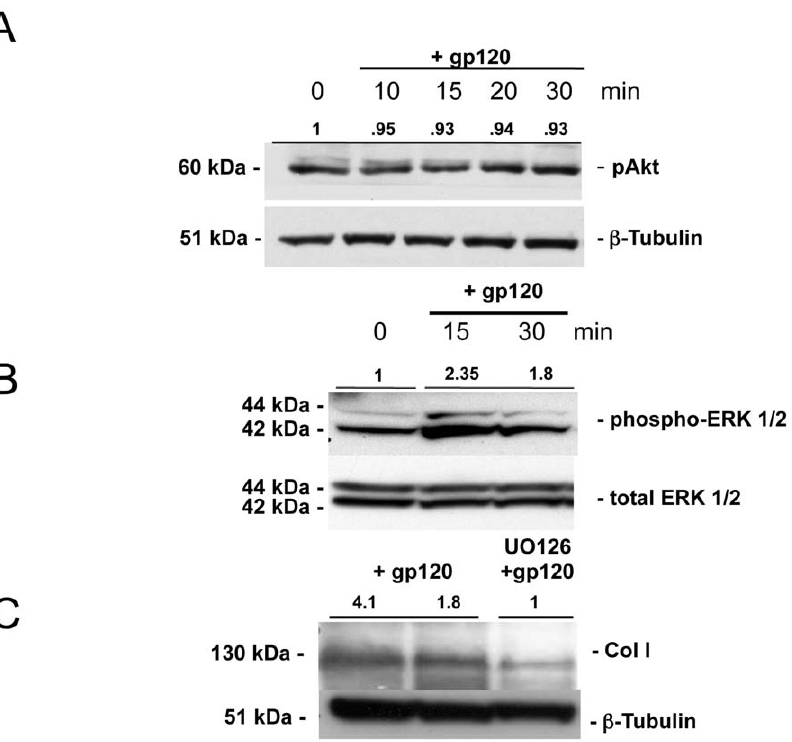
Figure 4. X4 gp120 induction of collagen I occurs via the ERK 1/2 pathway. (A, B) To determine whether X4 gp120 activates PI3K-Akt and/or ERK 1/2 pathways, primary HSCs were incubated with 500 ng/ml of X4 gp120 and levels of phospho-Akt and phospho-ERK 1/2 assessed by Western blot. An increase in phospho-ERK 1/2 was seen while no increase in phospho-Akt was seen in response to X4 gp120. (C) Pretreatment of cells with ERK inhibitor (UO126; 10 nM) 30 minutes prior to gp120 treatment resulted in a marked decrease in X4 gp120-induced collagen I protein expression in HSCs. ß-tubulin and total ERK1/2 were used as loading controls. Representative Western blots of three independent experiments with normalized densitometric units shown.